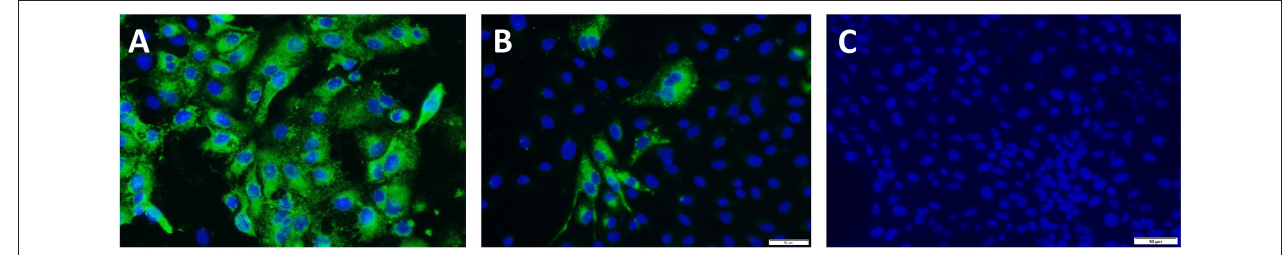
FIGURE 2 | Amplification test for viral inactivation: Immunofluorescence images of vaccine viruses at the 3rd passage. Green cytoplasmic fluorescence is indicative of viral replication and blue fluorescence localizes to the nucleus of the infected Vero cells. Images were obtained by staining with a PEDV-specific polyclonal antibody.